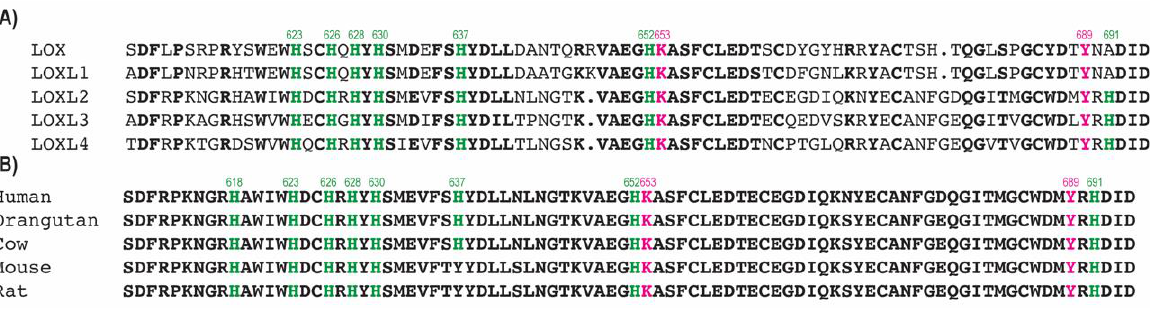
Figure 9. Conserved His residues (in green) in the active site of the LOX-family of proteins ( A ) and mammalian LOXL2s ( B ). The LTQ precursor residues are in pink. Residue numbers are those of human LOXL2. Table 3. Properties and kinetic parameters of LOXL2 in cadaverine oxidation.